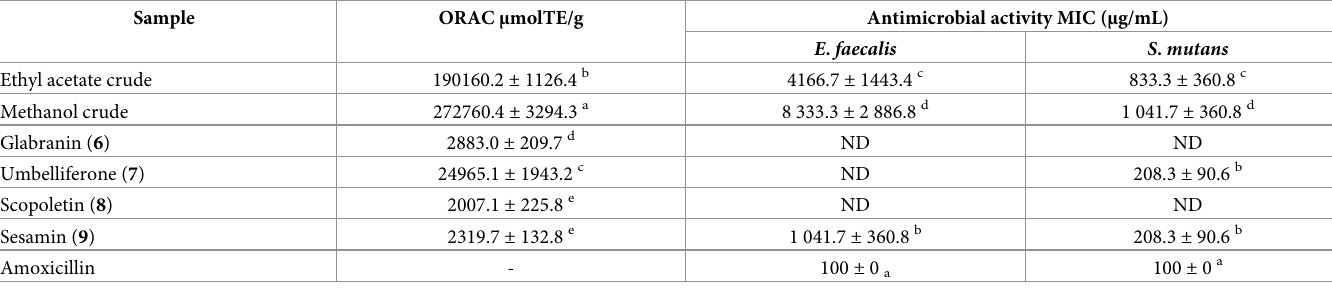
Table 1. Biological activities of M . glabra crude extracts and their isolated compounds.